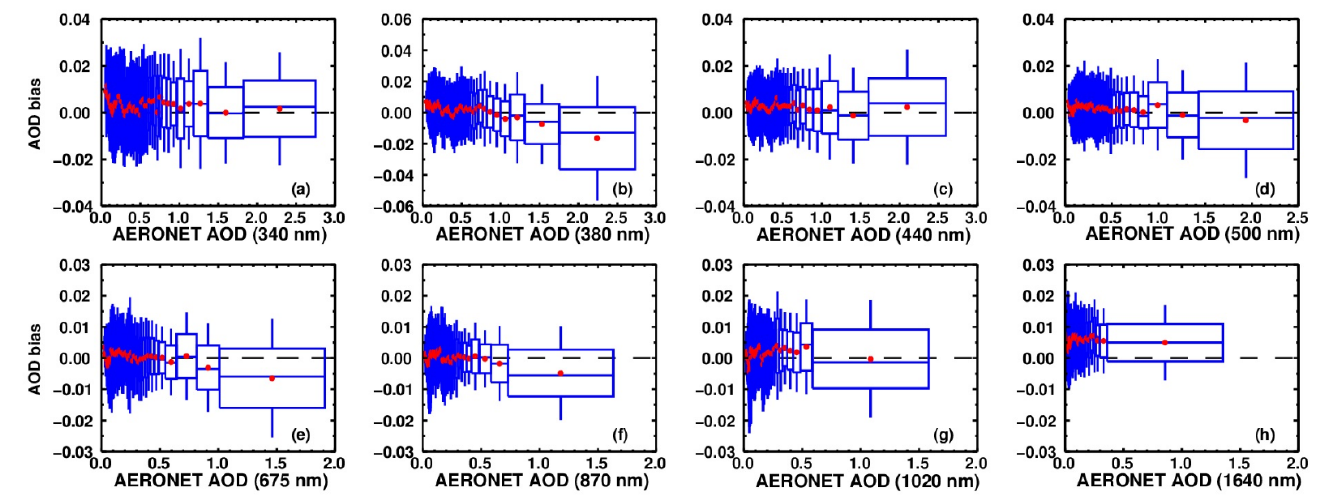
Figure 10. Box plots of the calculated AOD bias at each wavelength (from 340 to 1640 nm ( a – h )) and AERONET AOD using the 25th and 75th percentiles with 20 bins. The dashed black line indicates zero bias. The red dots, middle line, and upper and lower hinges represent the mean and median of the AOD bias and the 25th and 75th percentiles, respectively.